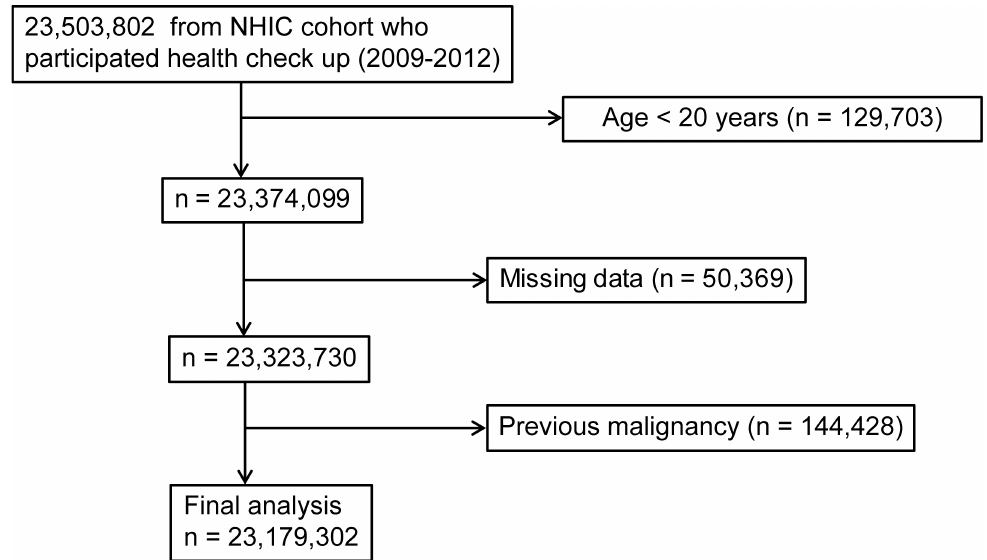
Fig 1. Flowchart showing the enrolment process for the study cohort. NHIC, NationalHealth Insurance